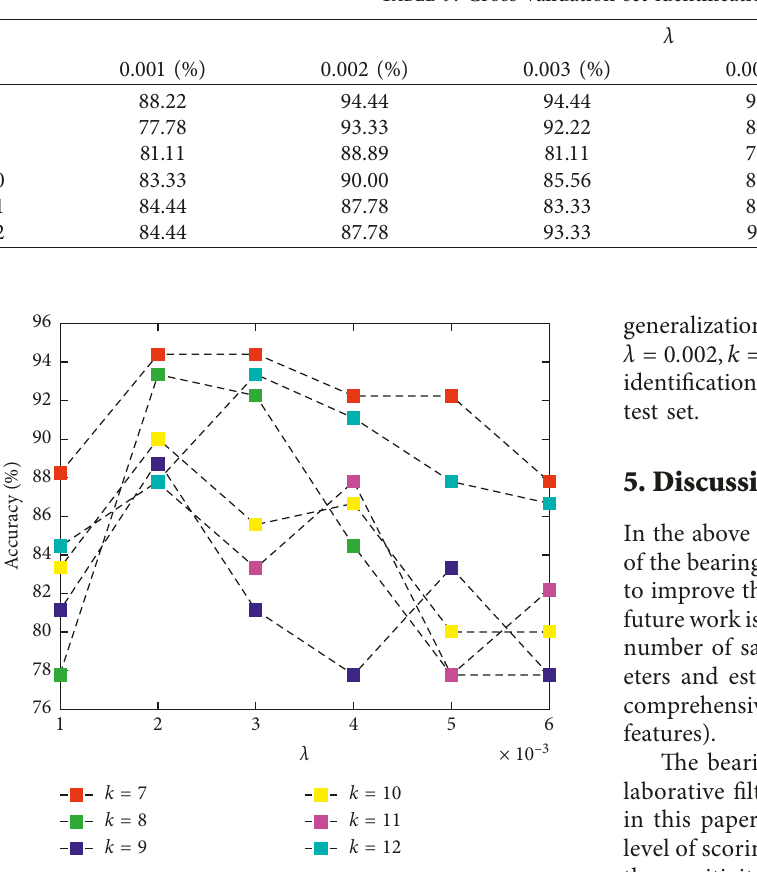
Figure 4: Cross-validation set identification